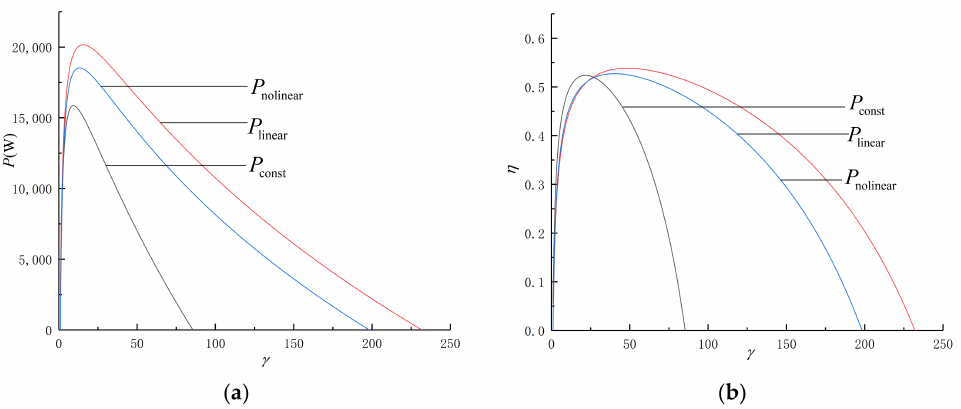
Figure 7. Effects of variable SH of WF on P and η . ( a ) Effects of variable SH of WF on P . ( b ) Effects of variable SH of WF on η .